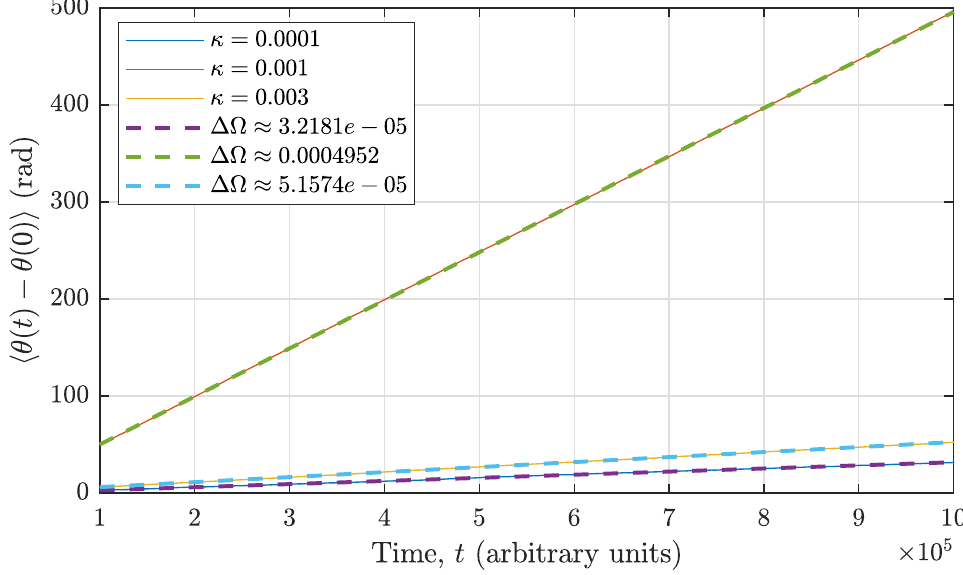
Figure 5. Average mismatch between dominant frequencies for different values of coupling strength κ . The slope of the fitted straight lines are the mean angular velocities.